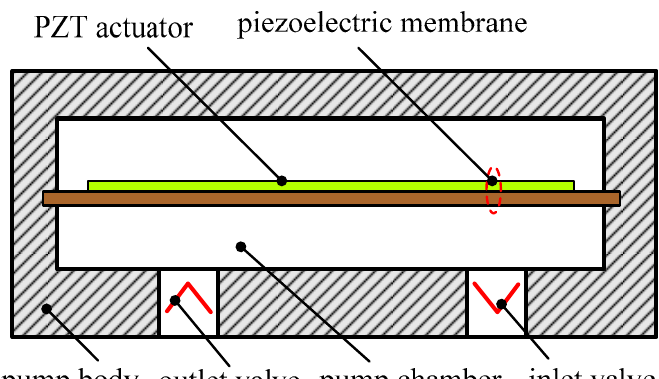
Figure 1. The structure of a classic piezoelectric membrane pump.